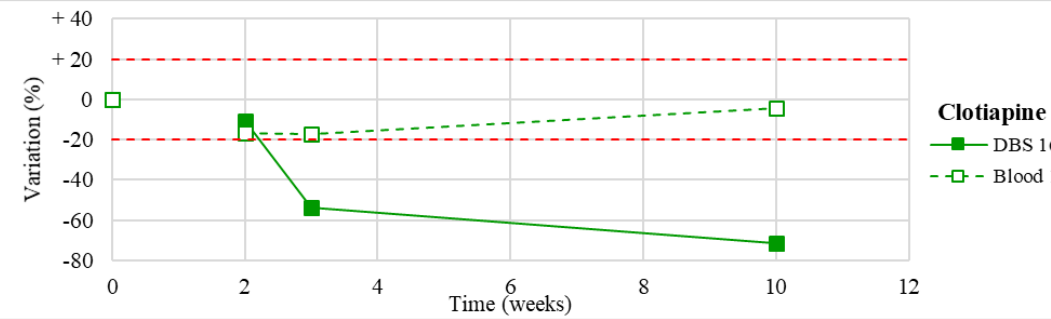
Figure 19. Long-term stability of clotiapine ( n = 1) in DBS stored at room temperature and in blood stored at −20 °C.